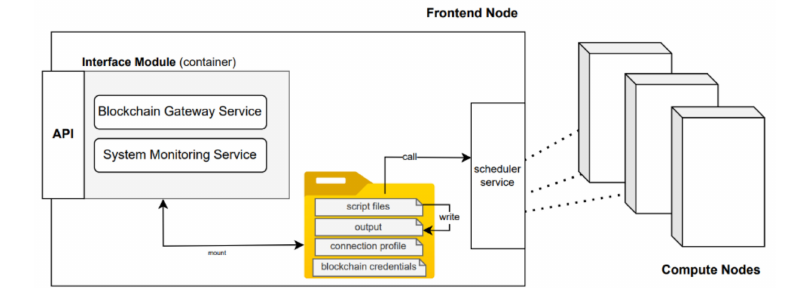
Figure 6. Interface Module.